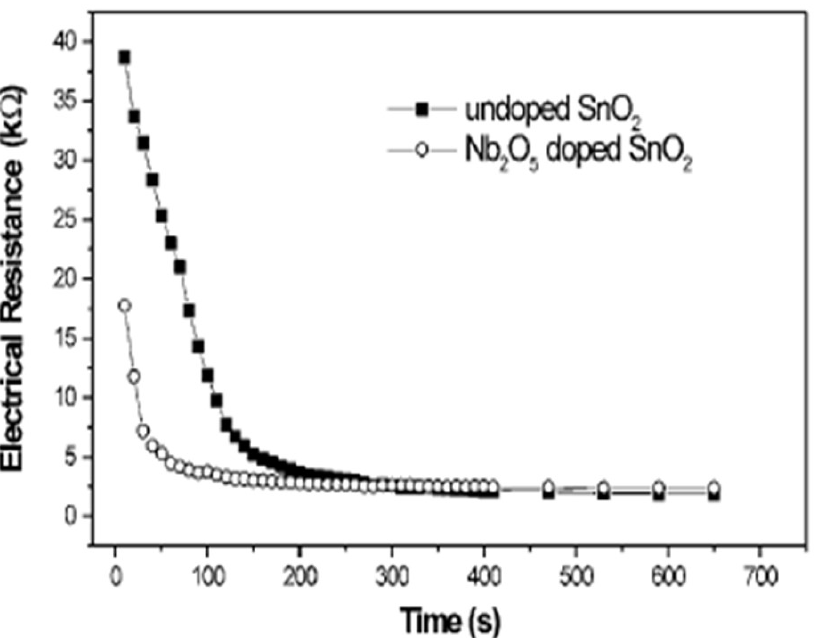
Figure 15. Time response of the Nb 2 O 5 -doped SnO 2 and undoped particles deposited by spin coating on alumina substrates with ethanol as the testing gas at 100 ppm. (Reprinted with permission from [78]. Copyright 2000, John Wiley and Sons).